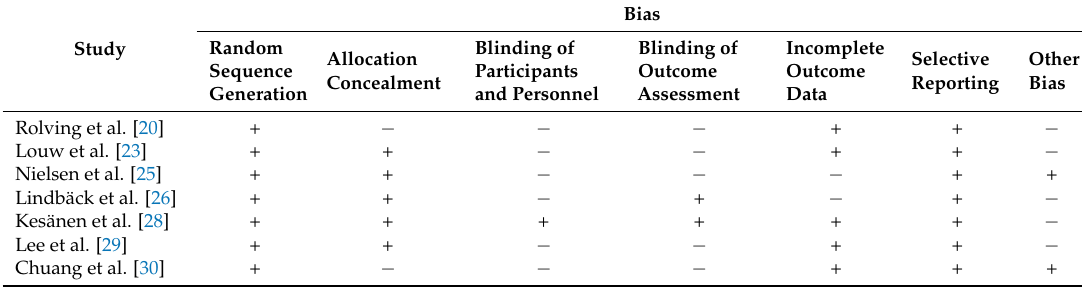
Table 4. Cochrane risk-of-bias